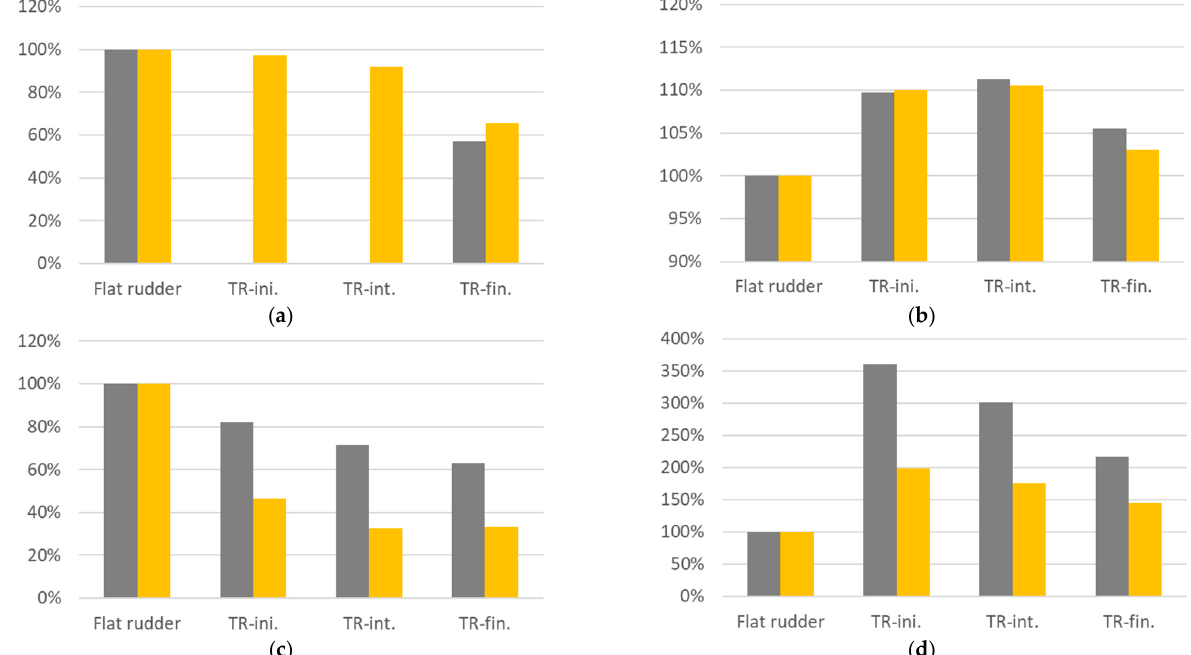
Figure 20. Qualitative comparisons of cavitation occurrence, rudder forces, and moment for the twin flat and twisted rudders: ( a ) cavitation amount; ( b ) total lift force; ( c ) maximum moment; ( d ) total drag force.